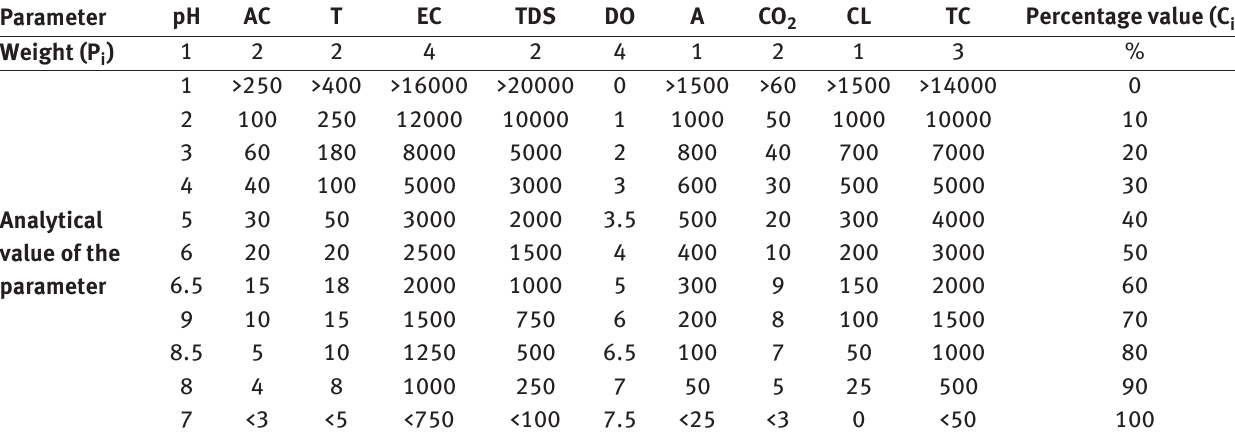
Table 2: Weight attributed (P i ) and percentage values (C i ) to the water quality parameters for calculation of the WQI B . Parameter Weight (P i